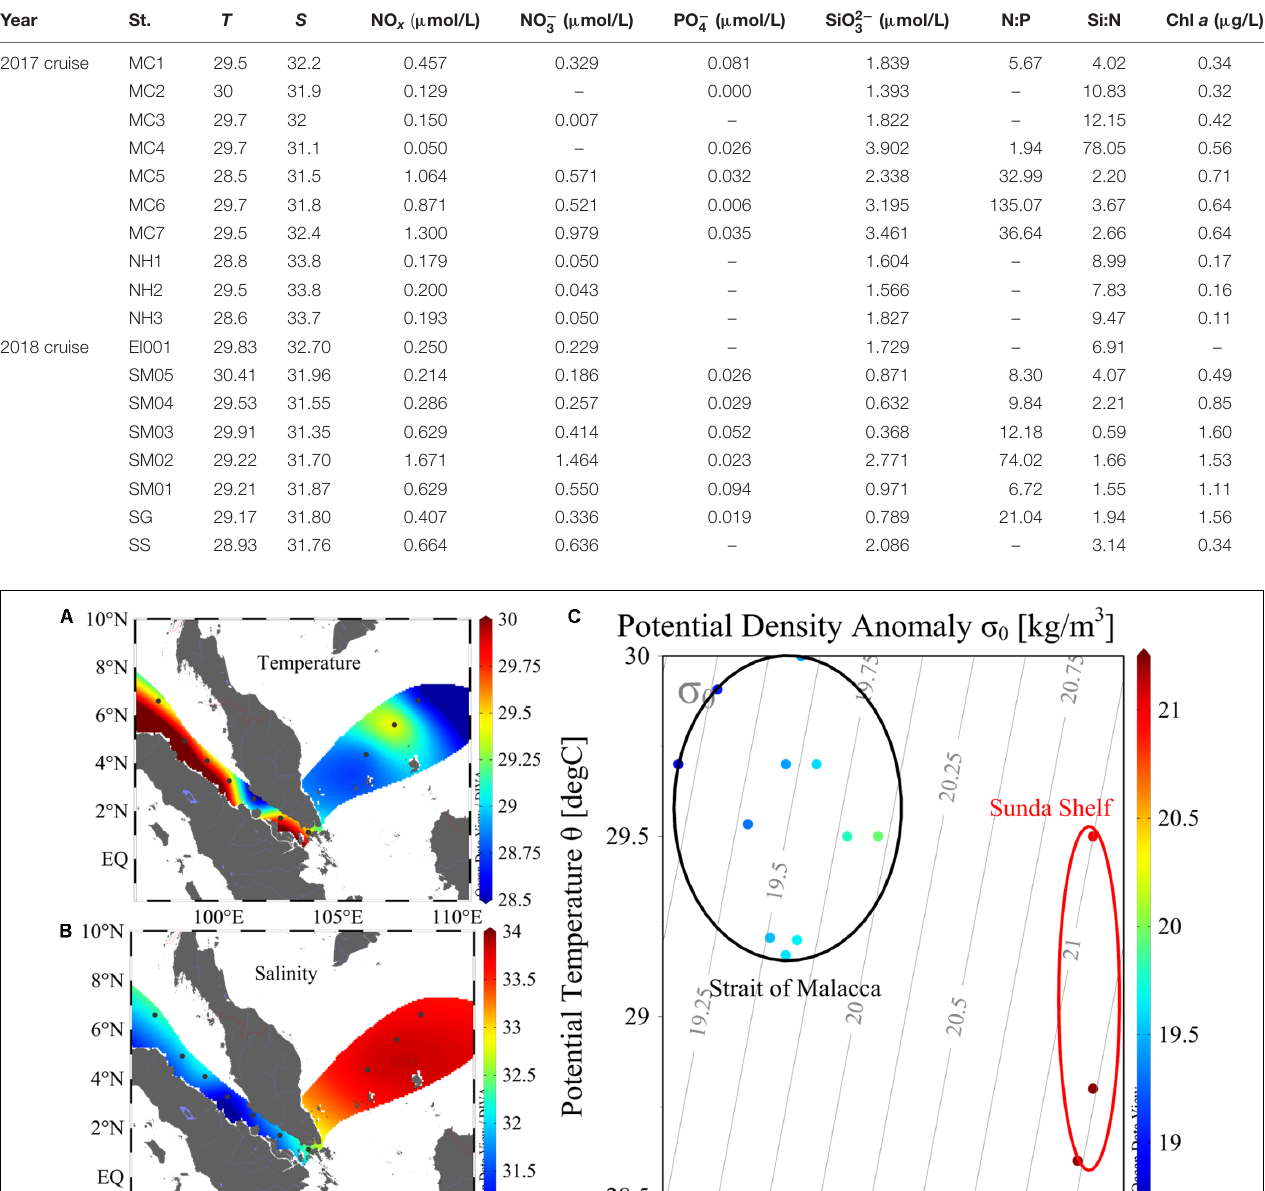
TABLE 1 | Temperature ( T ), salinity ( S ), nutrients and chlorophyll a (chl a ) in each station (St.). Year St.